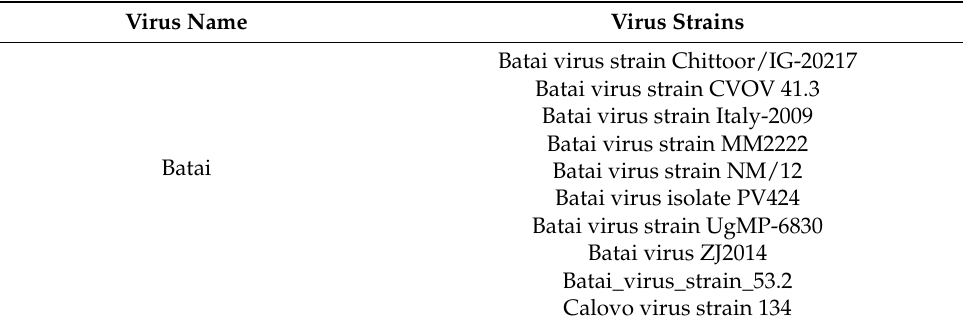
Table A1. Viruses used in this